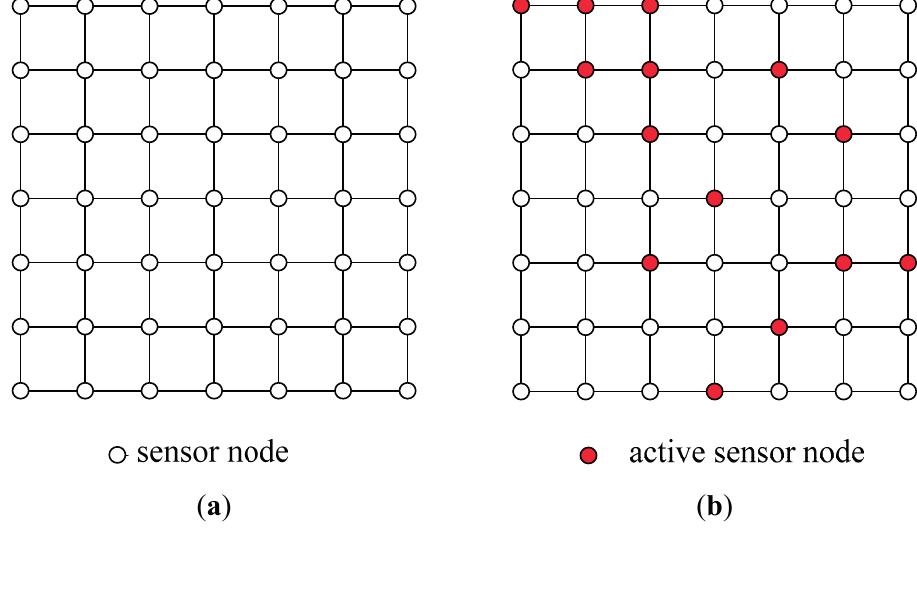
Figure 1. Sensor network. ( a ) Sensor network; ( b ) Active sensor nodes; ( c ) Sensor network; ( d ) Reconfigured